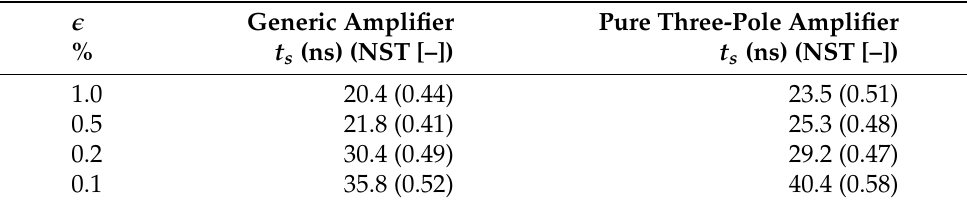
Table 1. Evaluation of the settling time, t s , for the generic amplifier and for the pure three-pole amplifier, at different accuracy levels. The amplifiers are designed setting ˆ K e = 8/3 and ˆ K i = 9/4. The NST is also reported for an effective